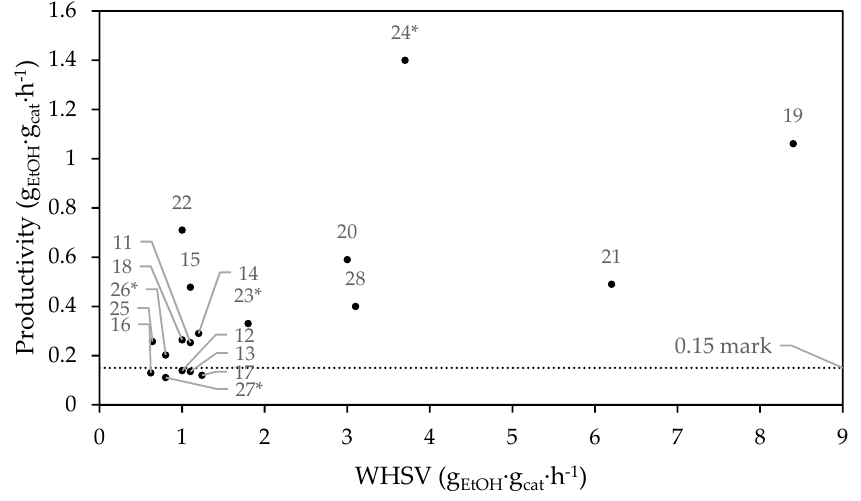
Figure 15. 1,3-Butadiene production versus weight hourly space velocity (WHSV) for the reviewed catalysts in reference to the ID number in Table 1. * indicates a result obtained from a two-step process.